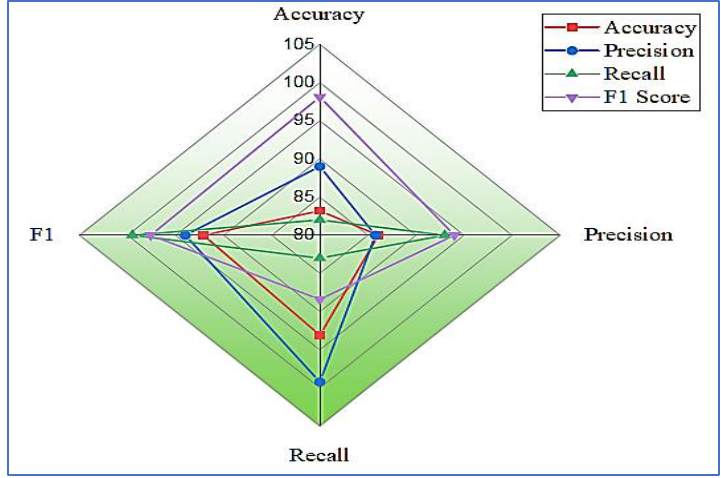
Figure 6. Model metrics for the teaching of agricultural higher vocational courses based on the BP neural network.